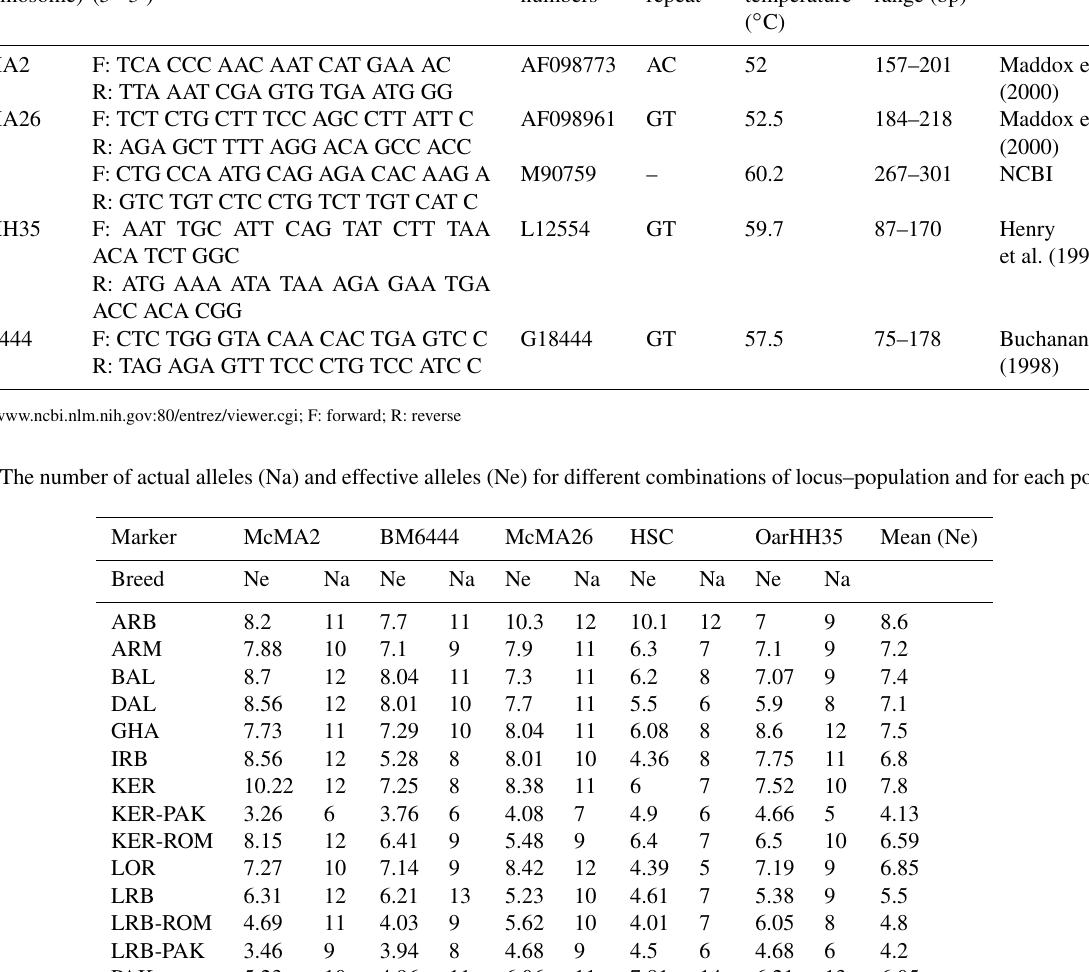
Table 1. Characteristics of selected microsatellite in present study. Marker Primers Accession Type of Annealing Allele size Reference (chromosome) (5 (cid:48) –3 (cid:48) )